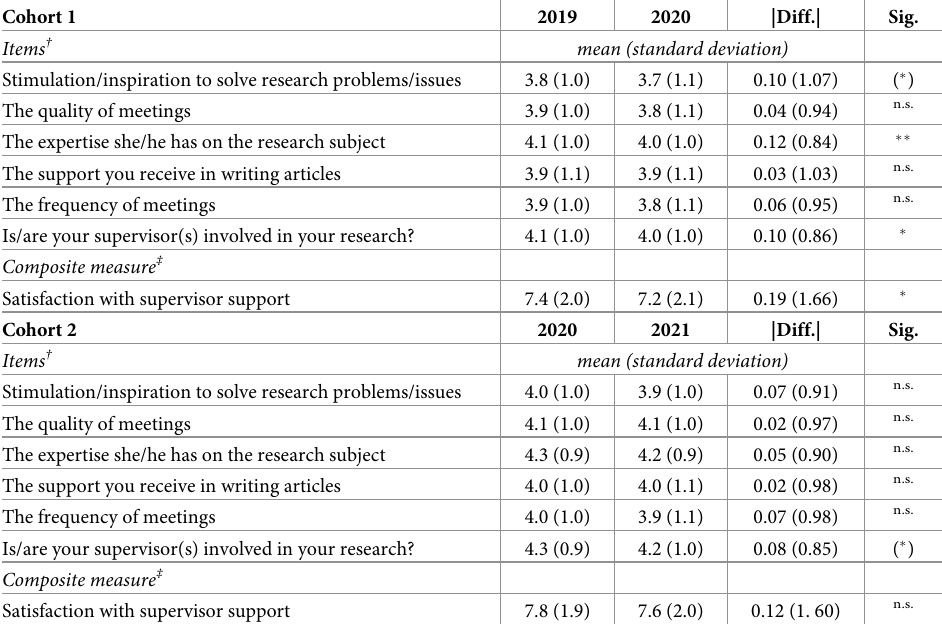
Table 3. Descriptive results scores on items on satisfaction with supervisor support and composite measure of overall satisfaction with supervisor support by cohort and years within